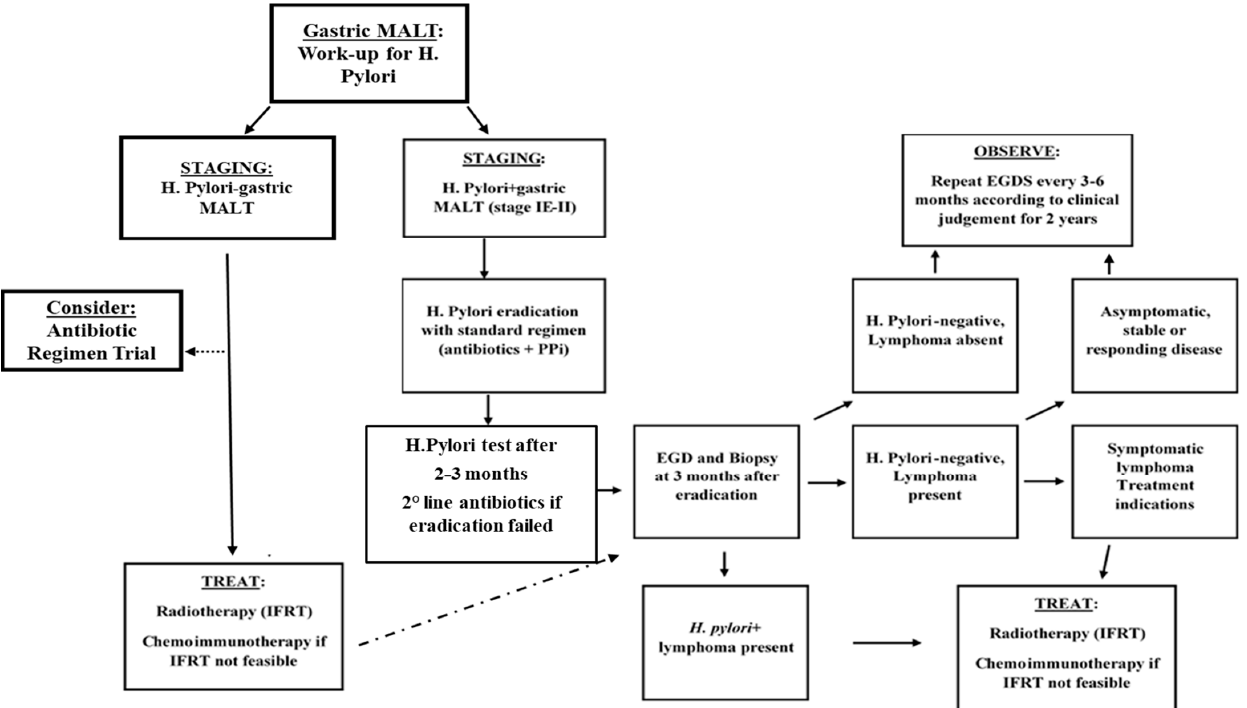
Figure 2. Treatment algorithm for stage IE-II gastric-MALT Lymphoma. H. pylori , Helicobacter pylori ; PPi, Proton pump inhibitors; EGDS, Esophagogastroduodenoscopy; IFRT, Involved field radiotherapy.